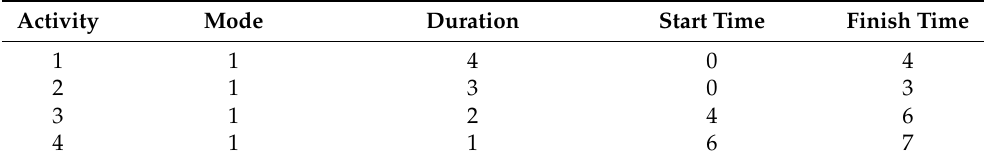
Table 2. Schedule of a sample project.